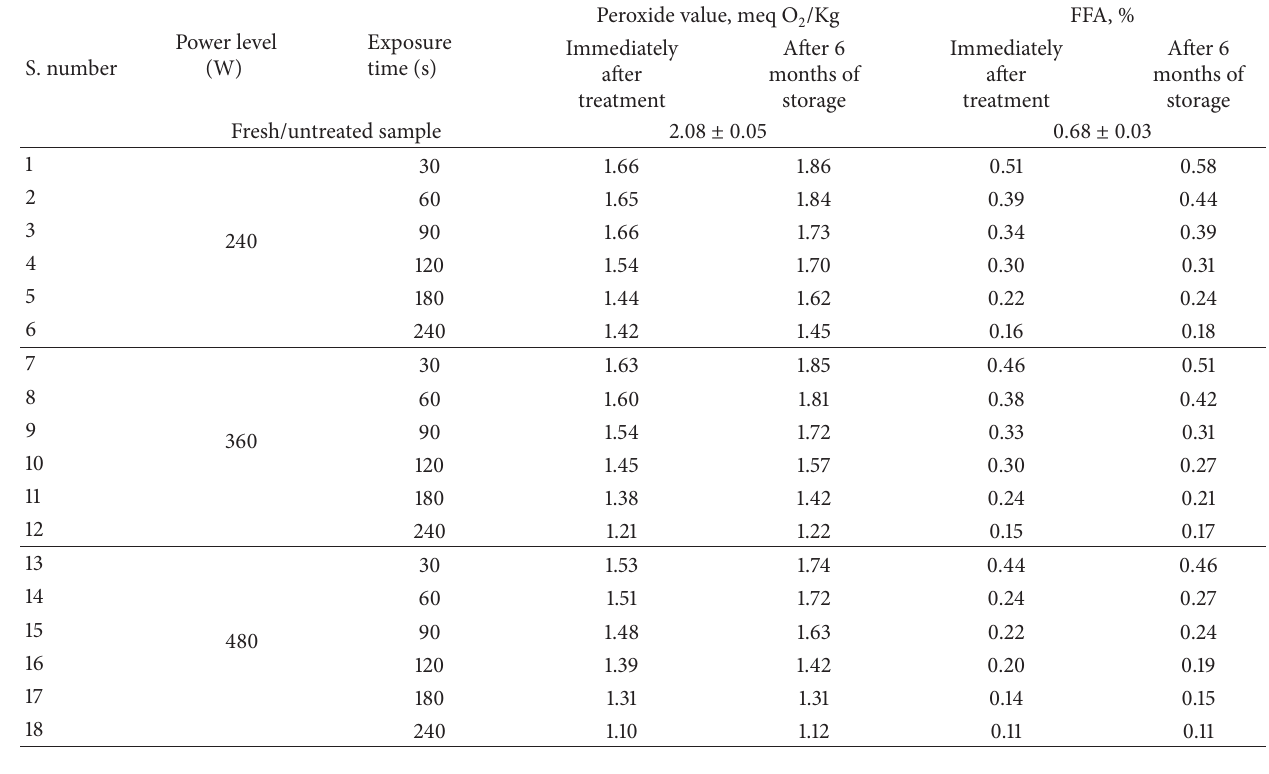
Table 4: Compositional analysis of cashew nut immediately after microwave treatment and after 6 months of storage under room conditions.